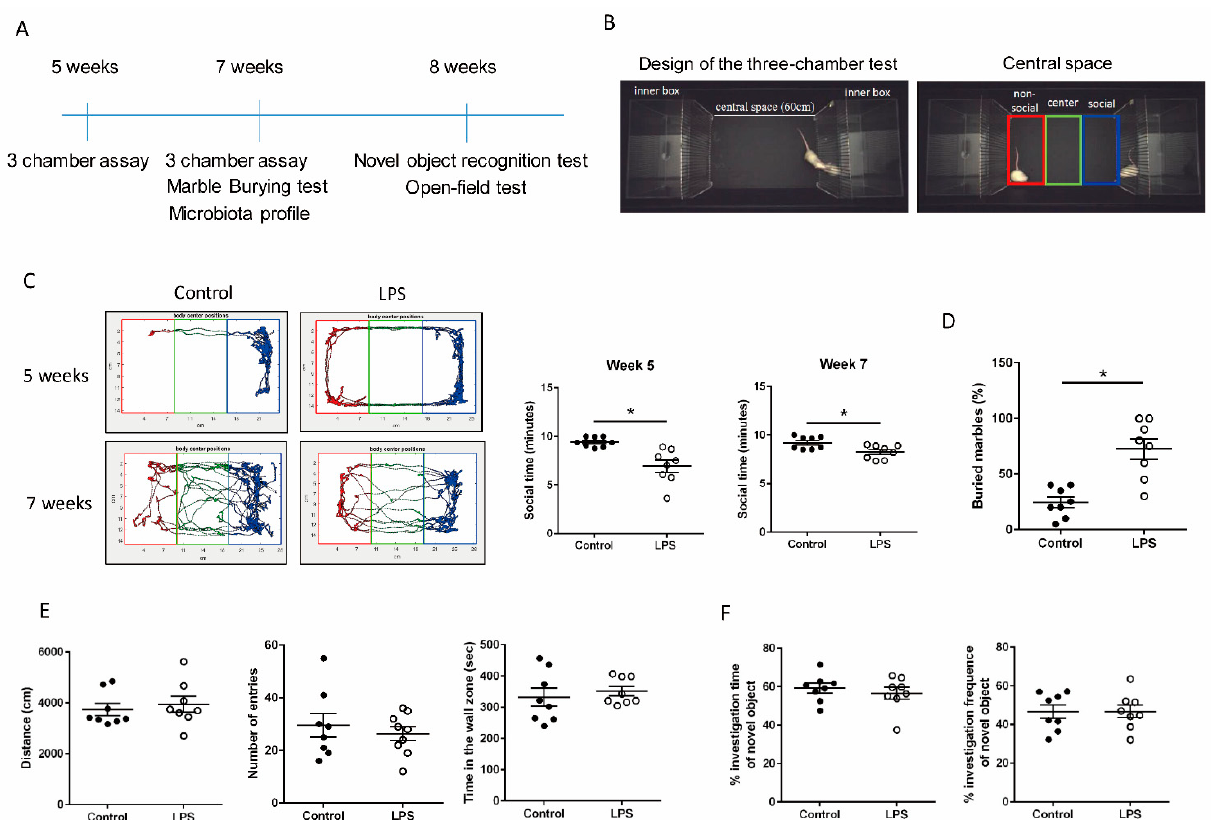
Figure 1. Maternal lipopolysaccharide (LPS) stimulation caused social behavior deficits and anxiety-like and repetitive behavior in male offspring. ( A ) Timeline for behavioral experiments. The age of the rats in weeks is indicated on the timeline. ( B ) Design of the three-chamber test apparatus for rats. The apparatus contained three parts: two side chambers and one central space. The length of the central space was 60 cm. The right-side chamber housed the stranger rat. The test rat was placed in the central space and allowed to freely interact with the stranger rat. The central space was divided into three regions: social, center, and nonsocial. ( C ) Quantification of time spent in the social region. The social behavior of 5- and 7-week-old maternal immune activation (MIA) and control offspring was detected using a three-chamber apparatus. Their tracks in the central space of the three-chamber apparatus are indicated, with the nonsocial region indicated in red, the center region in green, and the social region in blue. * p < 0.05 ( n = 8 per group). ( D ) Percentage of buried marbles in the MIA and control offspring. * p < 0.05 ( n = 8 per group) ( E ) Locomotor activity evaluation was performed in 7-week-old MIA and control male offspring using the open-field test ( n = 8 per group). ( F ) The NOR test was performed on 7-week-old MIA and control male offspring ( n = 8 per group). All data are presented as mean ±